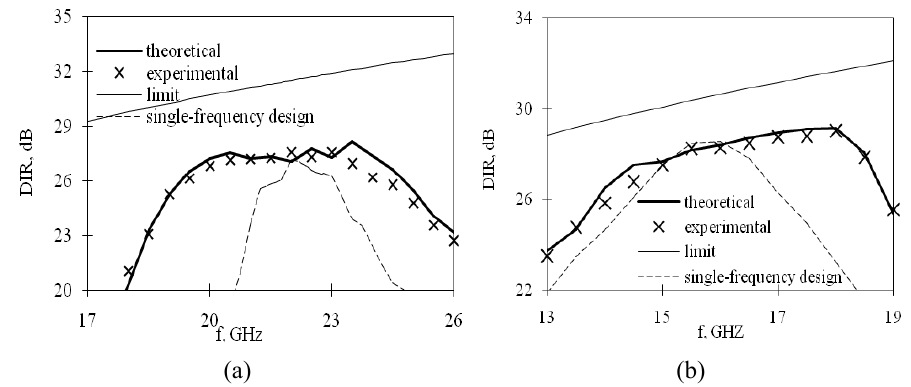
Fig. 7. Theoretical and experimental results for: (a) the single-layer antenna; (b) the two-layer